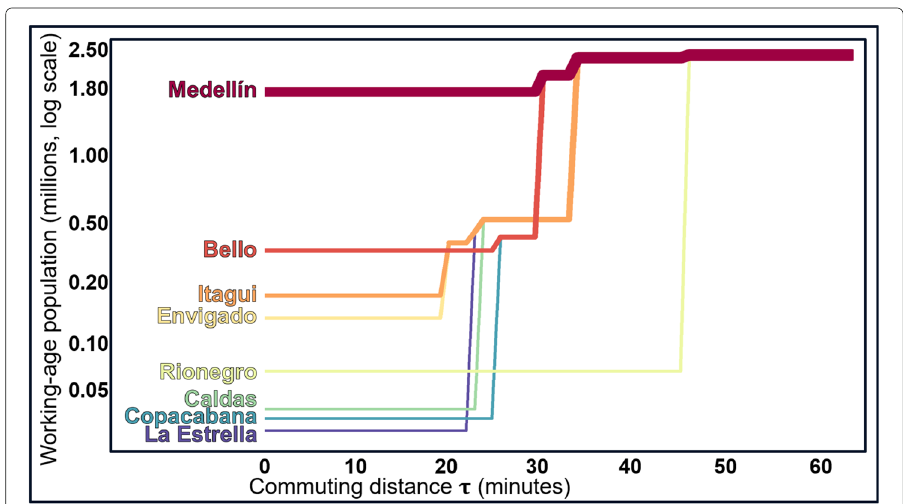
Fig. 4 In the case of Medellín and its surrounding municipalities, the working-age population increases from 1.7 million at τ = 0 (single municipality) to nearly 2.6 million by τ = 49 minutes by which time eight urban municipalities are